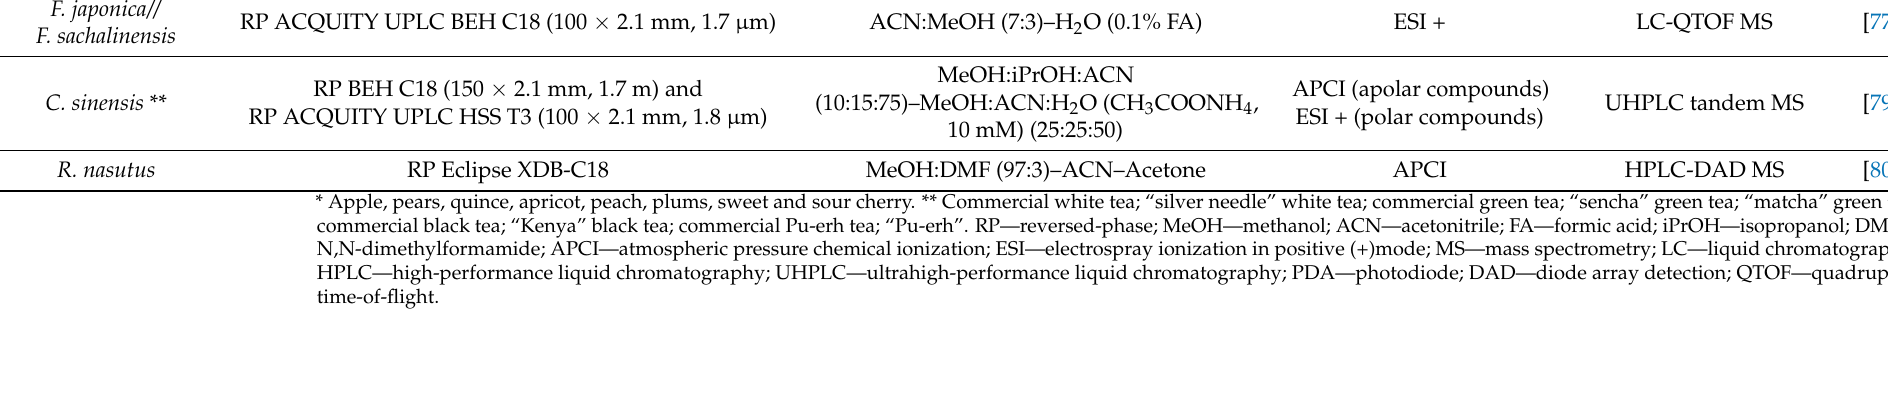
Table 8. Chlorophylls—chromatography and mass spectrometry details. Plant Column Eluent Ionization Source Mass Analysers Ref Fruit tree leaves